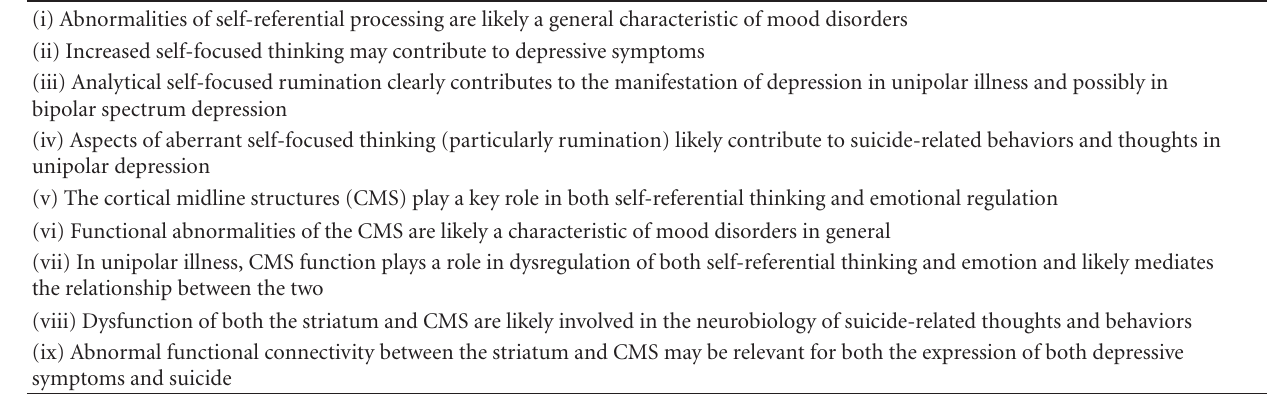
Table 1: Conclusions from studies